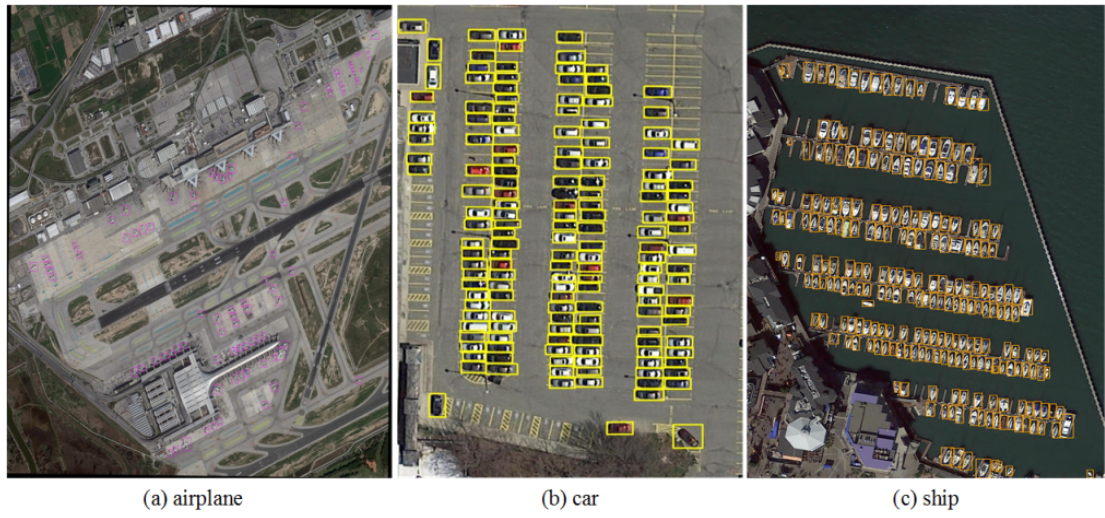
Figure 11. Some instances of detection results obtained by NEOON with three categories (( a ) airplane; ( b ) car; ( c ) ship).